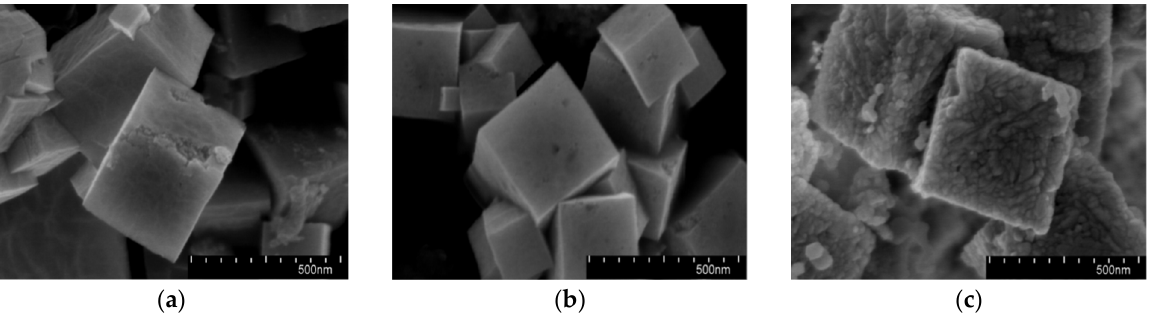
Figure 3. SEM images of freshly deposited ZnSn(OH) 6 ( a ) and after its calcination at 520 °C ( b ) and 700 °C ( c ).